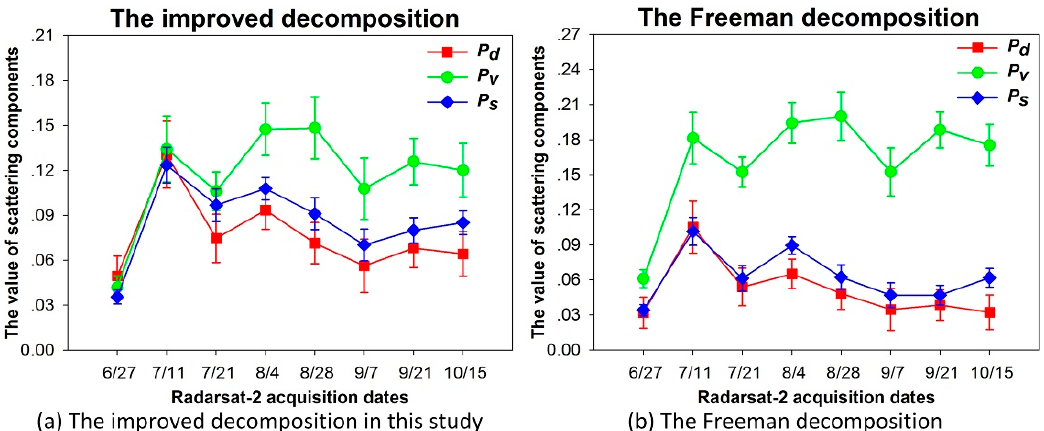
Figure 7. ( a , b ) The results of improved three-component polarimetric decomposition and the Freeman-Durden decomposition. Table 2. Numbers of negative pixels in six rice fields.